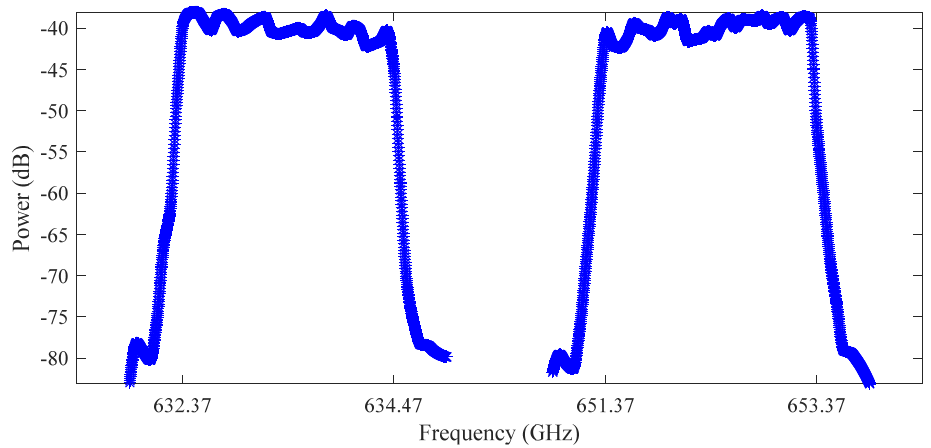
Figure 6. The simulated SRF spectrums with 3 dB in-band fluctuations for both sidebands. The radiometer receives the thermal noise of the targets, and the amount of radiation is a measure of the energy magnitude of the thermal noise. In the simulation process, we used the brightness temperature spectrum obtained from ARTS as the scene target, and we set up the hot and cold targets with uniform brightness temperature. In general, we use Gaussian white noise to represent thermal noise, which can be modeled for both hot and cold targets with uniform brightness temperature. According to the noise spectrum per unit radiation amount, we can get the input noise signal of the scene target, hot target, and cold target. The power spectrum obtained was not accurate because the influence of SRF is superimposed in the RF front-end model. The power spectrum after the integration time of 5 ms is shown in Figure 7.